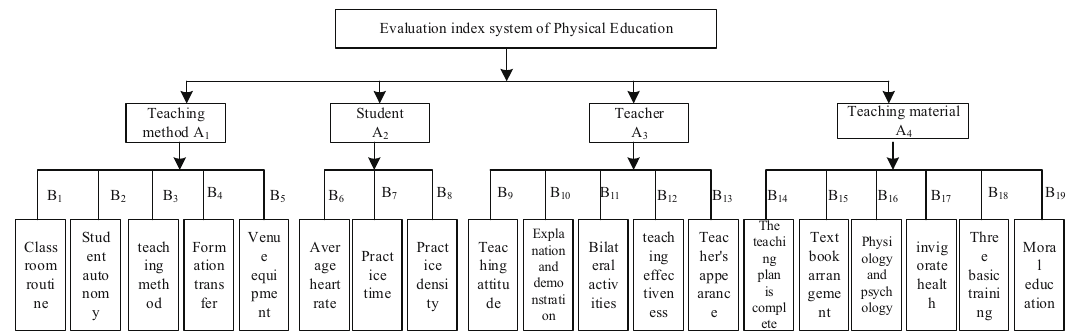
Figure 3: Teaching evaluation index system